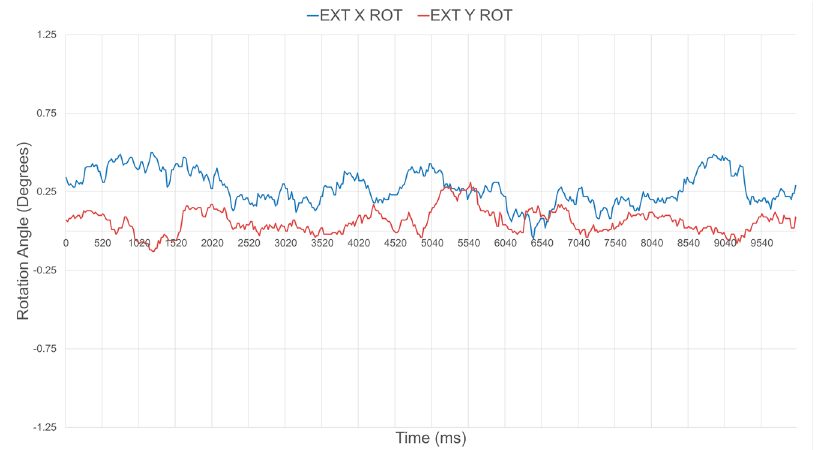
Figure 18. Uncalibrated orientation estimates for ground truth relative orientation of a surface with 0° rotation about both the X and Y axes.